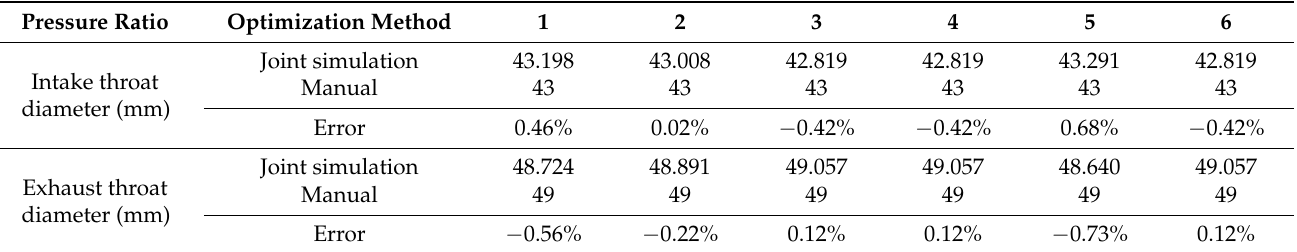
Table 7. Comparison of joint simulation optimization results and manual optimization